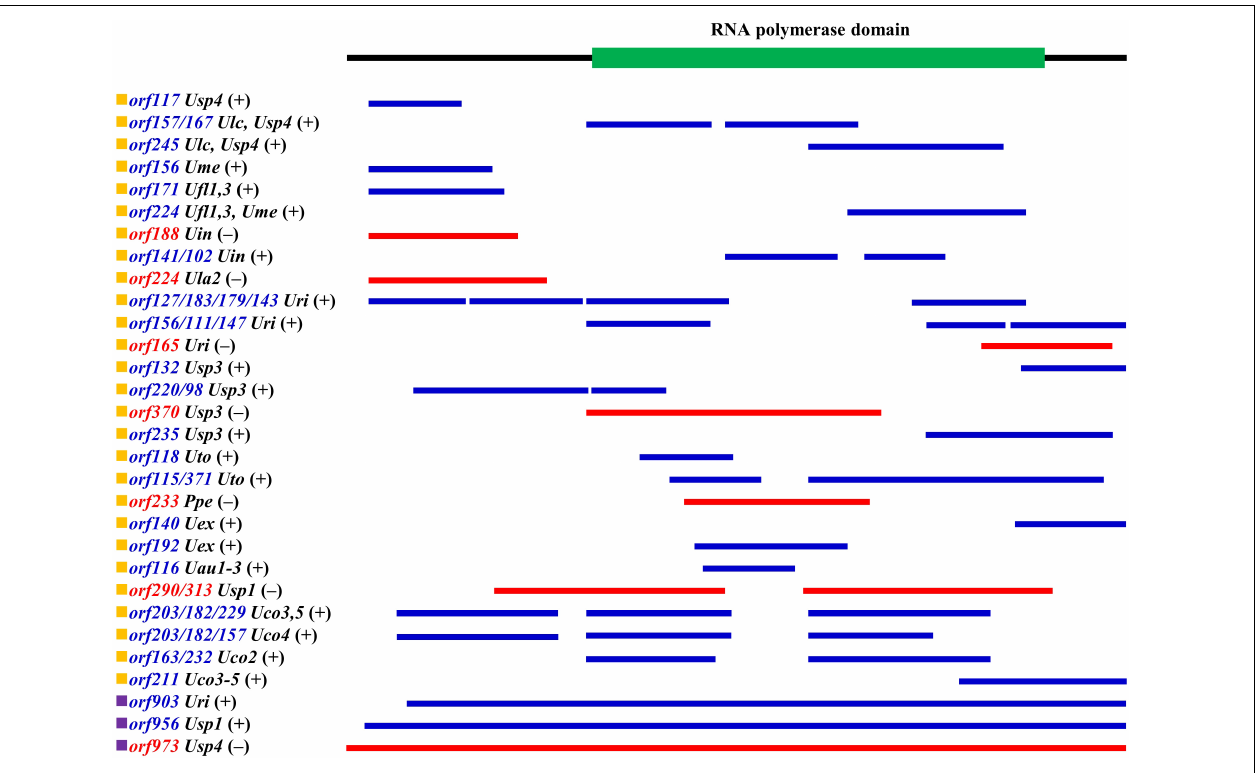
FIGURE 4 | The schematic alignment of three full-length and 55 split RNA polymerase (Rpo) proteins in ulvalean mitogenomes. Proteins shown in blue are transcribed on the same chain as the core genes, and proteins shown in red are transcribed on the minus strand. The core Rpo domains which was identified in Rpo proteins by Pfam are displayed above the